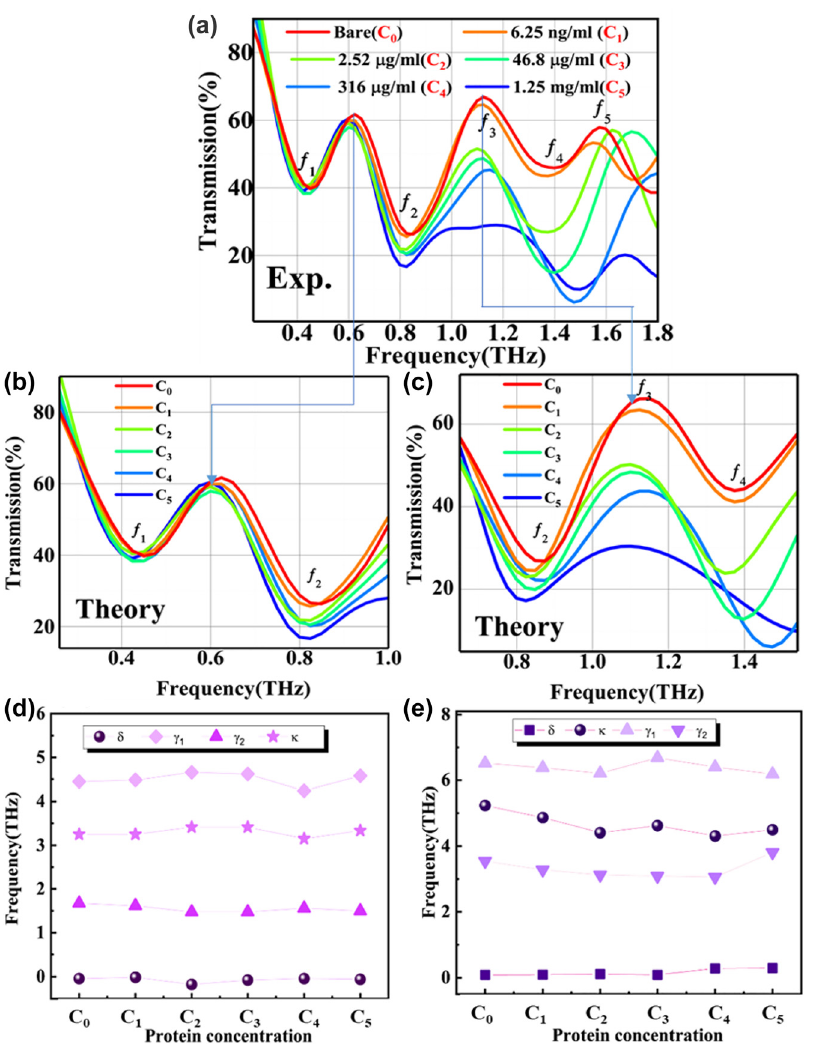
Table  : Comparison with previous works based on THz sensors. Material Analytes LOD Sensing type IMG [Reference] MOSLS + MS (EIT) WP  .  ng/ml Amplitude + No π – π stacking This work Frequency + Phase MS (EIT) MDK  .  ug/ml Amplitude + frequency No π – π stacking [  ] Graphene + MS Fructose  ng/ml Amplitude No π – π stacking [  ] Graphene + PI CMM  ng/ml Amplitude π – π stacking [  ] Graphene + MS CMM  ng/ml Amplitude π – π stacking [  ] LOD, limit of detection; IMG, the interaction between external molecules and graphene; WP, whey protein. MS, metasurface; EIT, electromagnetically induced transparency; PI, polyimide; MDK, Midkine; CMM, chlorpyrifos methyl molecules.